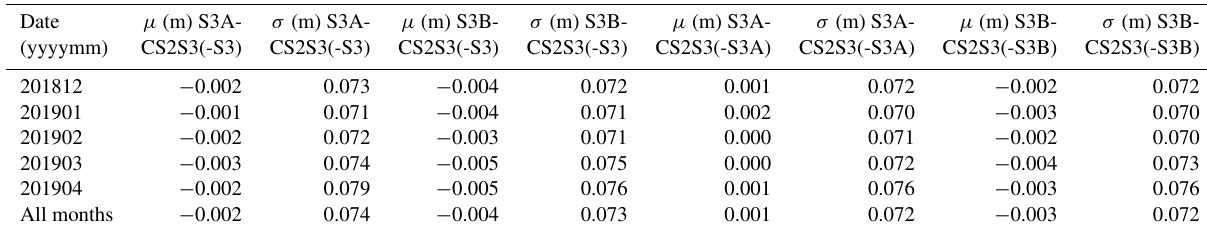
Figure 6. Scatter–density plots and error distributions of the GPR predictions for all days between the 1 December 2018 and the 24 April 2019, with different combinations of S3 satellites removed from the training data. (a) Model trained using only CS2 observa- tions, validated against S3A. (b) Model trained using only CS2 observations, validated against S3B. (c) Model trained using only CS2 and S3B observations, validated against S3A. (d) Model trained using only CS2 and S3A observations, validated against S3B. Grey shading is used to indicate 1 σ either side of the mean µ for each histogram. Only values within ± 3 σ of the mean are shown for the histogram plots. Table 2. Mean ( µ ) and standard deviation ( σ ) of the daily difference between gridded S3A and S3B tracks and co-located CS2S3 points, with different combinations of S3 observations removed from the training